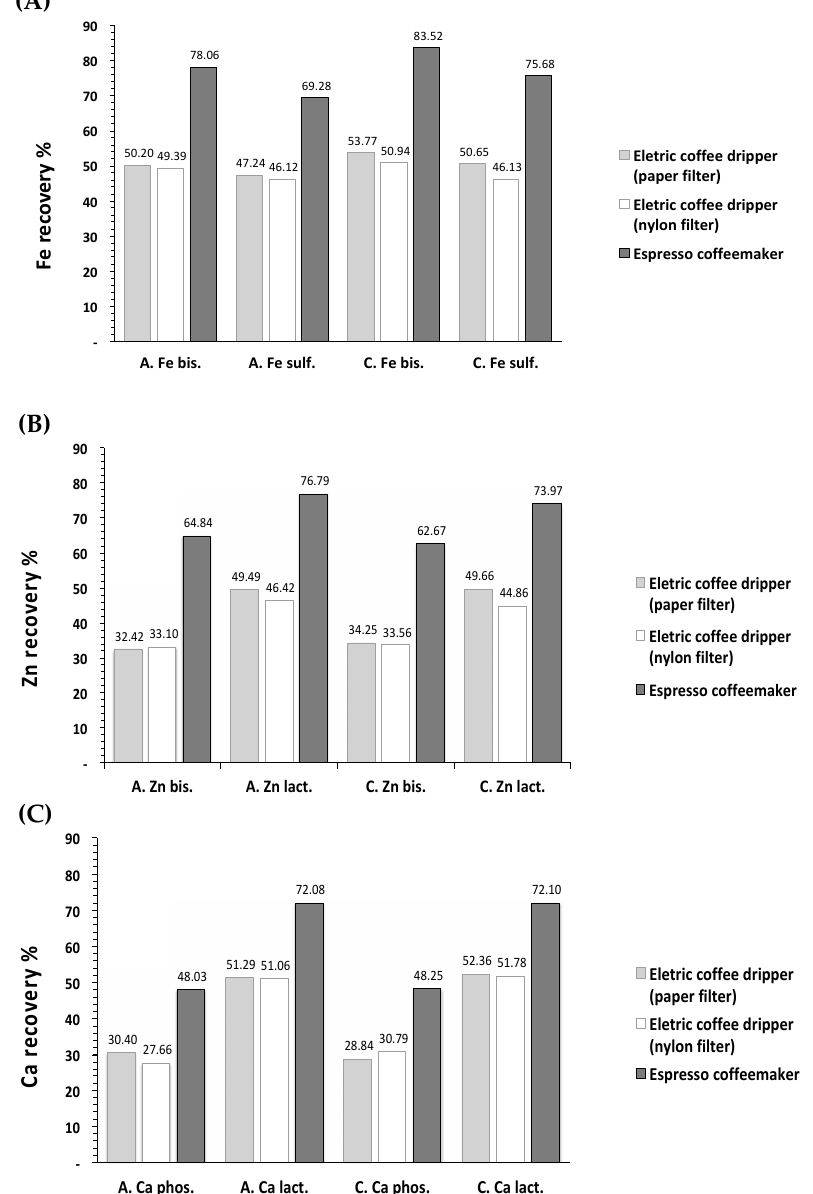
Figure 3. Mean percent recovery of iron ( A ), zinc ( B ), and calcium ( C ) in brews prepared from fortified ground roasted C. arabica and C. canephora using an electric dripper (paper and nylon filters) and espresso machine. § Note: Recovery was calculated based on the sum of the amount of mineral existing in the matrix and the added amount of salt. A Fe bis— C. arabica , ferrous bisglycinate chelate; A. Fe sulf.— C. arabica , ferrous sulfate; C. Fe bis— C. canephora , ferrous bisglycinate chelate; C. Fe sulf.— C. canephora , ferrous sulfate.; A Zn bis— C. arabica , zinc bisglycinate chelate; A. Zn lact.— C. arabica , zinc lactate; C. Zn bis— C. canephora , zinc bisglycinate chelate; C. Zn lact.— C. canephora , zinc lactate; A Ca phos— C. arabica , calcium phosfate; C Ca phos— C. canephora , calcium phosfate; A Ca lact— C. arabica , calcium lactate; C Ca lact— C. canephora , calcium